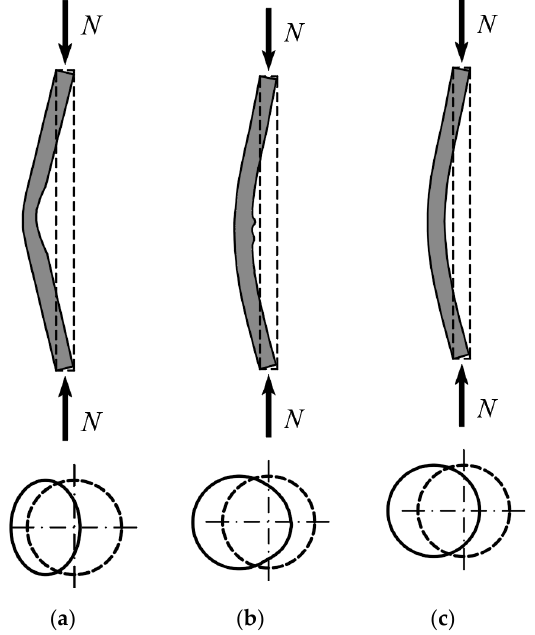
Figure 6. Typical failure modes of slender and moderately slender circular columns: ( a ) steel column, global + local buckling; ( b ) CFST column, global and local buckling; ( c ) CFST column, only elastic global buckling, based on [27,44].